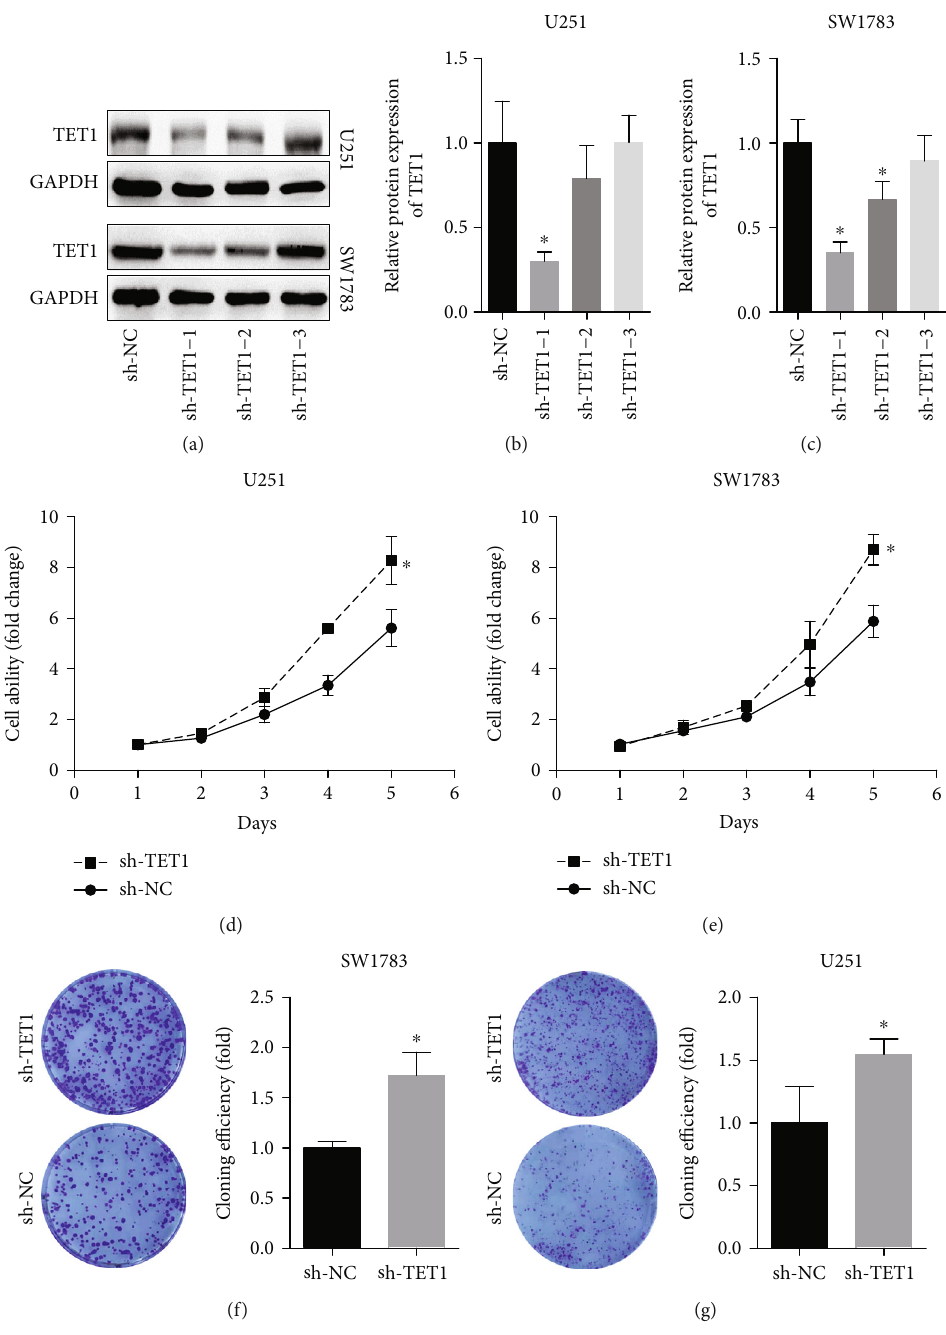
Figure 2: Downregulation of TET1 enhanced the proliferation ability of U251 and SW1783 cells. (a, b) The e ffi ciency of TET1 shRNAs was detected by RT-qPCR. (b, c) CCK8 assay was performed to test the proliferation of U251 and SW1783 cells. (d, e) Colony formation assay was used to con fi rm the ability of cell proliferation. ∗ P < 0 : 05